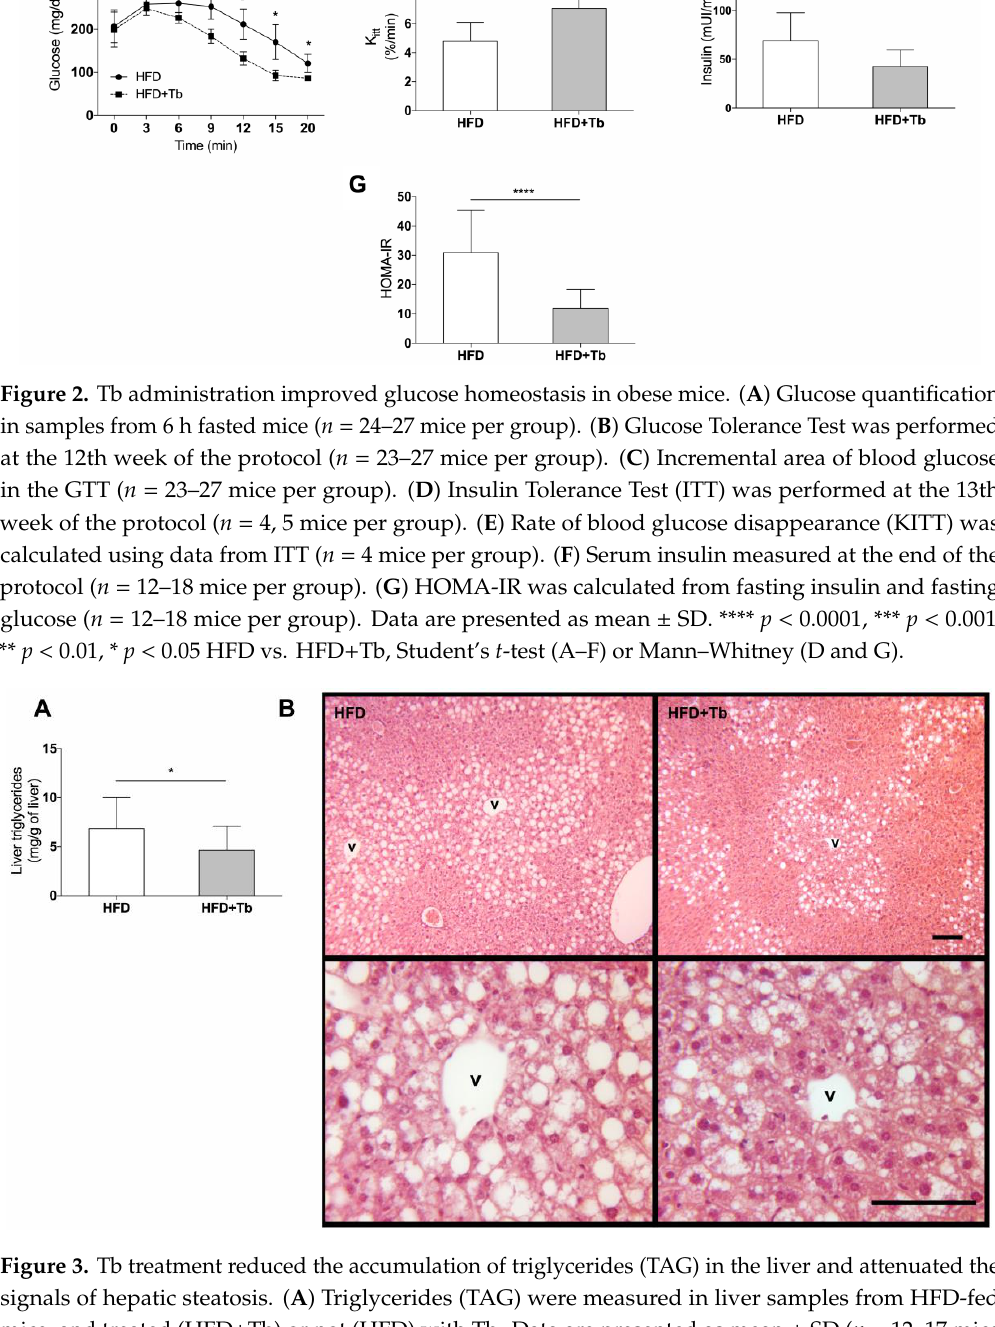
Figure 3. Tb treatment reduced the accumulation of triglycerides (TAG) in the liver and attenuated the signals of hepatic steatosis. ( A ) Triglycerides (TAG) were measured in liver samples from HFD- fed mice, and treated (HFD+Tb) or not (HFD) with Tb. Data are presented as mean ± SD ( n = 12–17 mice per group). * p < 0.05 HFD vs. HFD+Tb, Student’s t- test. ( B ) Representative image of the